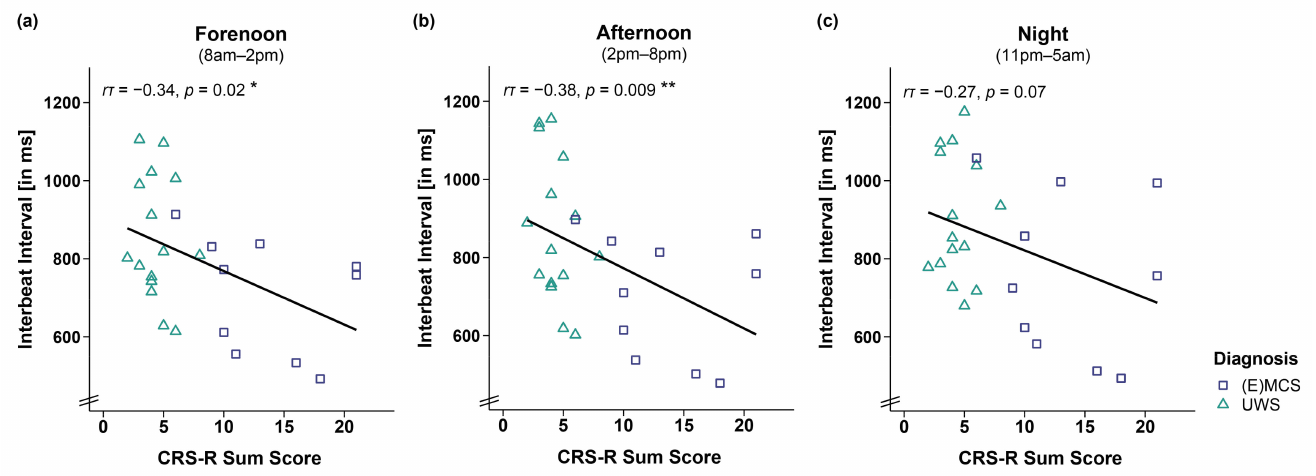
Figure 2. Correlation between interbeat interval (IBI) and CRS-R sum score separately for time. Larger IBIs were associated with lower CRS-R sum scores throughout the ( a , b ) day (i.e., forenoon, afternoon) and ( c ) night. Please note that the effect during the night is no longer ‘credible’ from a Bayesian point of view, and will not be interpreted. ** p < 0.01; * p < 0.05. Abbreviations: (E)MCS = (emergence